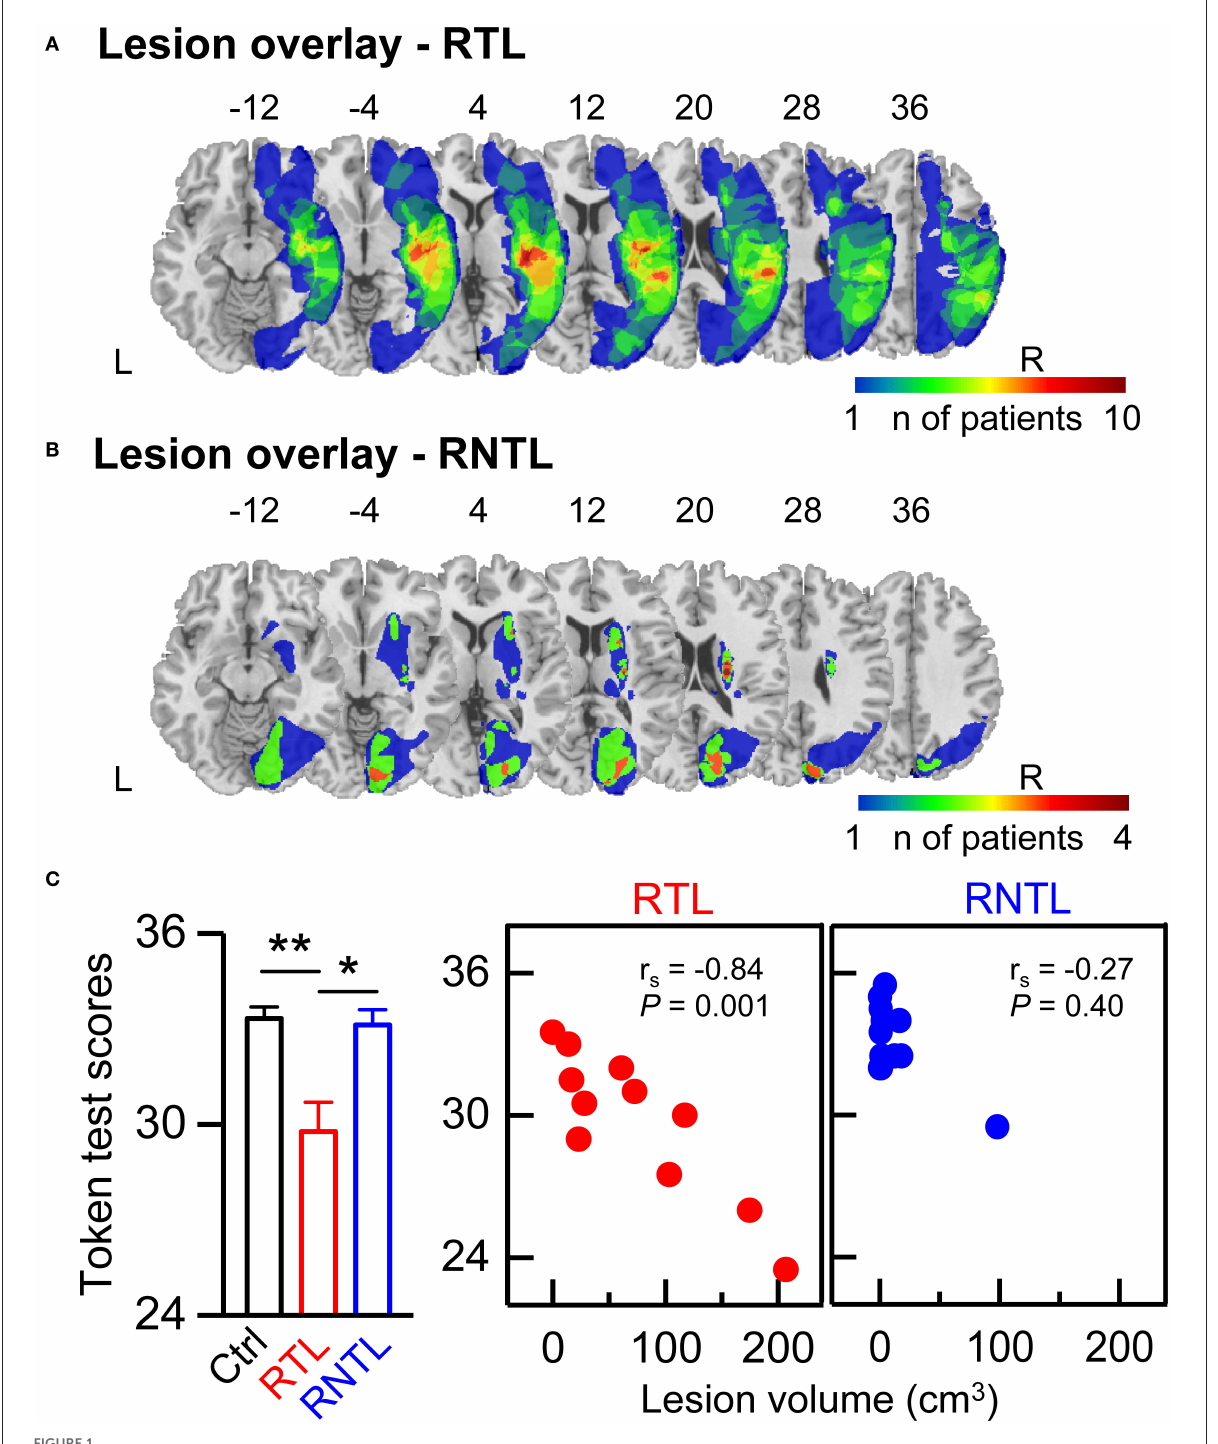
FIGURE1 Lesion overlay map and speech comprehension ability. (A,B) The lesion overlap map of patients with right temporal lobe (RTL) damage (A) and right non-temporal lobe (RNTL) damage (B) . The heat map displays the number of patients with lesions in that respective area. Coordinates refer to MNI space. (C) Token test scores in each group. Token test scores of the RTL group were lower than that of the control group and that of the RNTL group (Left). The values are expressed as mean ± SE. * P < 0.05, ** P < 0.01. Significantly negative correlation was found between lesion volume and Token test scores in the RTL group only (Central), but not the RNTL group (Right). r s represents the correlation coefficient. L, left; R,